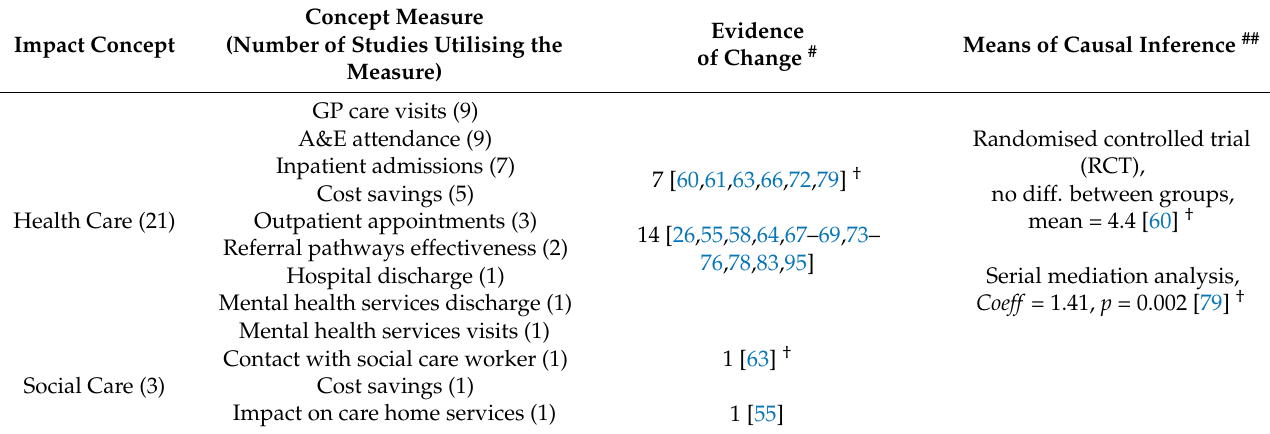
# Studies showing statistically significant change between pre- and post-measures for a target population/group of interest, with these measures clearly defined and connected to key outcomes. ## Studies implementing a research design or can claim a causal link between the social prescribing intervention and the changes they find due to research design (RCT), statistical matching, or other rigorous means of causal inference. † Studies published in peer-reviewed outlets. Just as with individual-level outcomes, the degree of change differs across